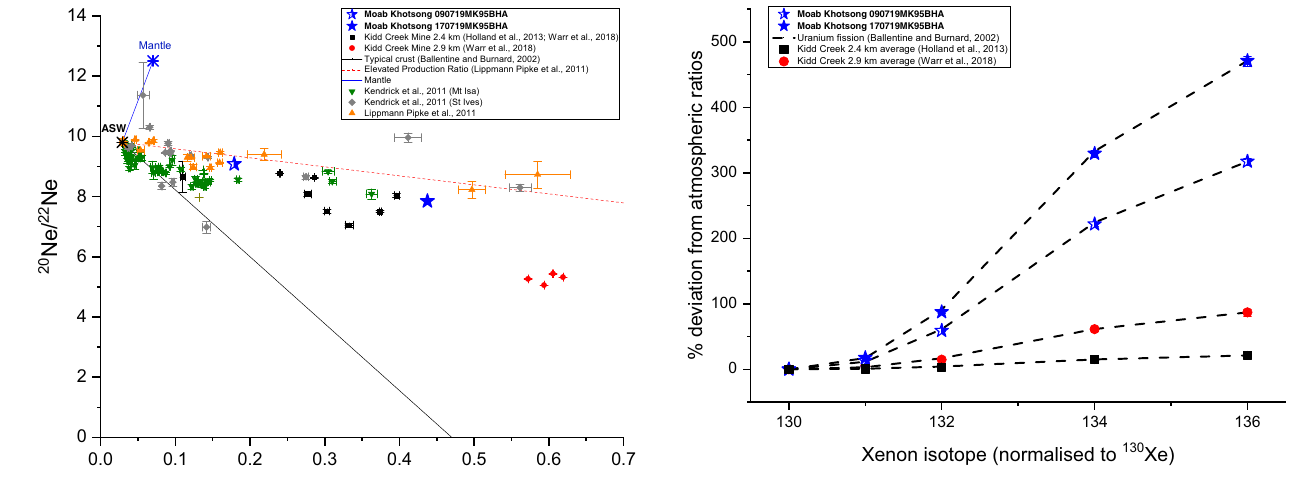
Fig. 2 131 – 136 Xe isotopic deviations from atmospheric ratios (expressed as percentages). Both Moab Khotsong samples (blue stars) reveal excesses over four times greater than those observed at Kidd Creek and in fl uid inclusions at Mt Isa 34 , where the highest excesses previously reported were found, as highlighted in Supplementary Table 2. Published Kidd Creek values 2 are plotted for context (black squares and red circles). The dashed lines correspond to the production of Xe via uranium fi ssion based on the measured 136 Xe excess and con fi rm that uranium fi ssion is the primary source of the heavy Xe isotopic excess in the Moab Khotsong brine. Sample 090719MK95BHA (half-shaded star) reveals a lower radiogenic excess for all noble gases and is consistent with a minor residual air component introduced during sampling (see Methods). Error bars represent analytical uncertainty at 1 σ and are smaller than the plotted